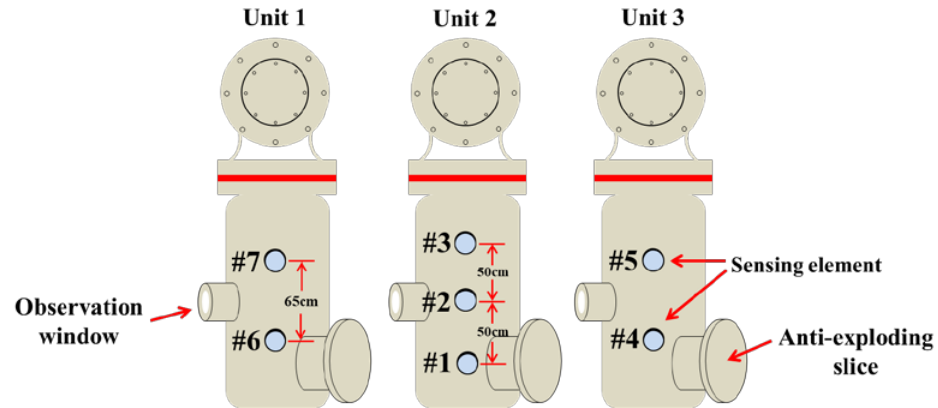
Figure 4. Deployment of sensing elements on the shell of GIS discharge defect simulation device.